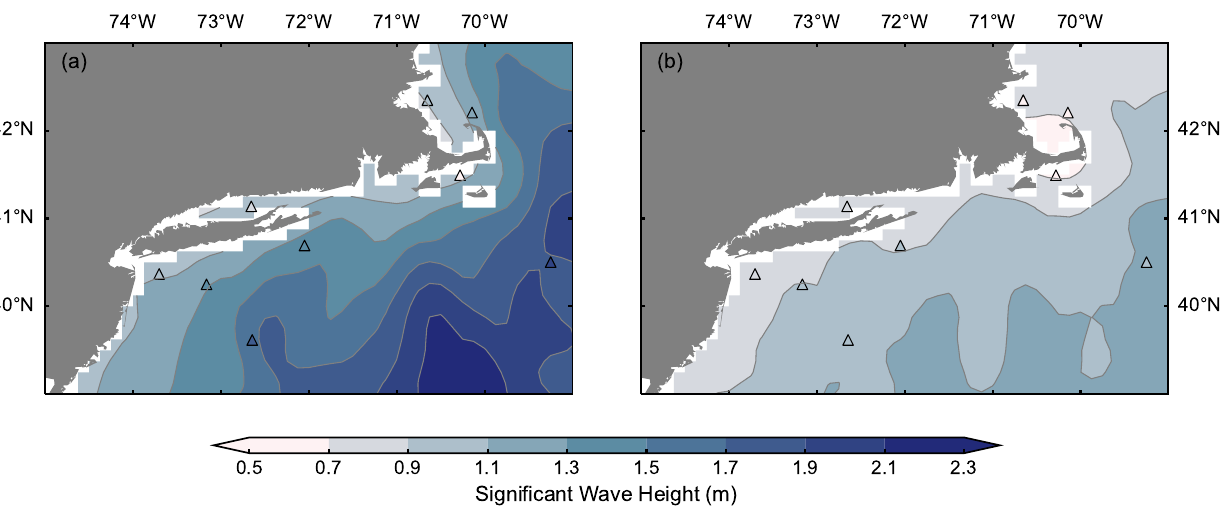
Figure 9. The SWH times composites for the 2019 and 2020 winter ( a ) and summer ( b ) seasons were created by interpolating data from the five altimeters used in this study. The colored triangles represent the collocated buoy average SWH values to evaluate the altimeter